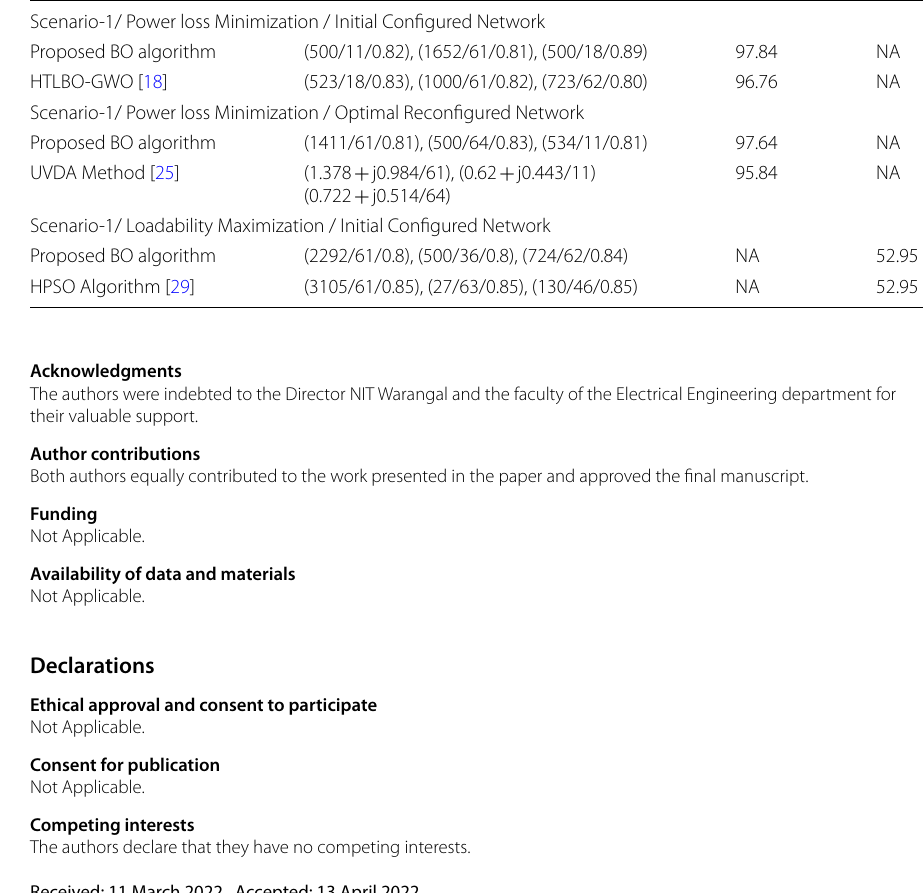
Table 8 Comparison results of 69 bus system Method DGs sizes in kW/BUS/